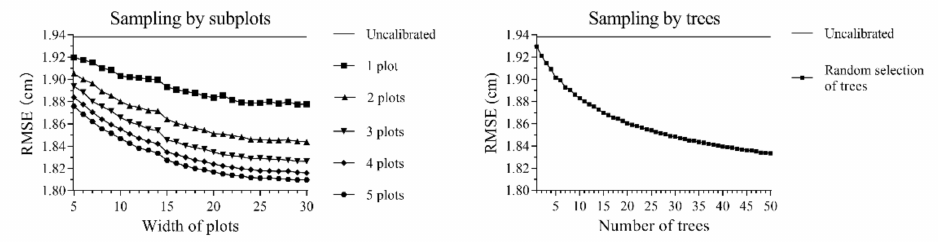
Figure 4. Root mean squared error (RMSE, in cm) for the uncalibrated prediction and local calibrated prediction of the nonlinear mixed-effects model with two sampling strategies (based on subplots and trees).